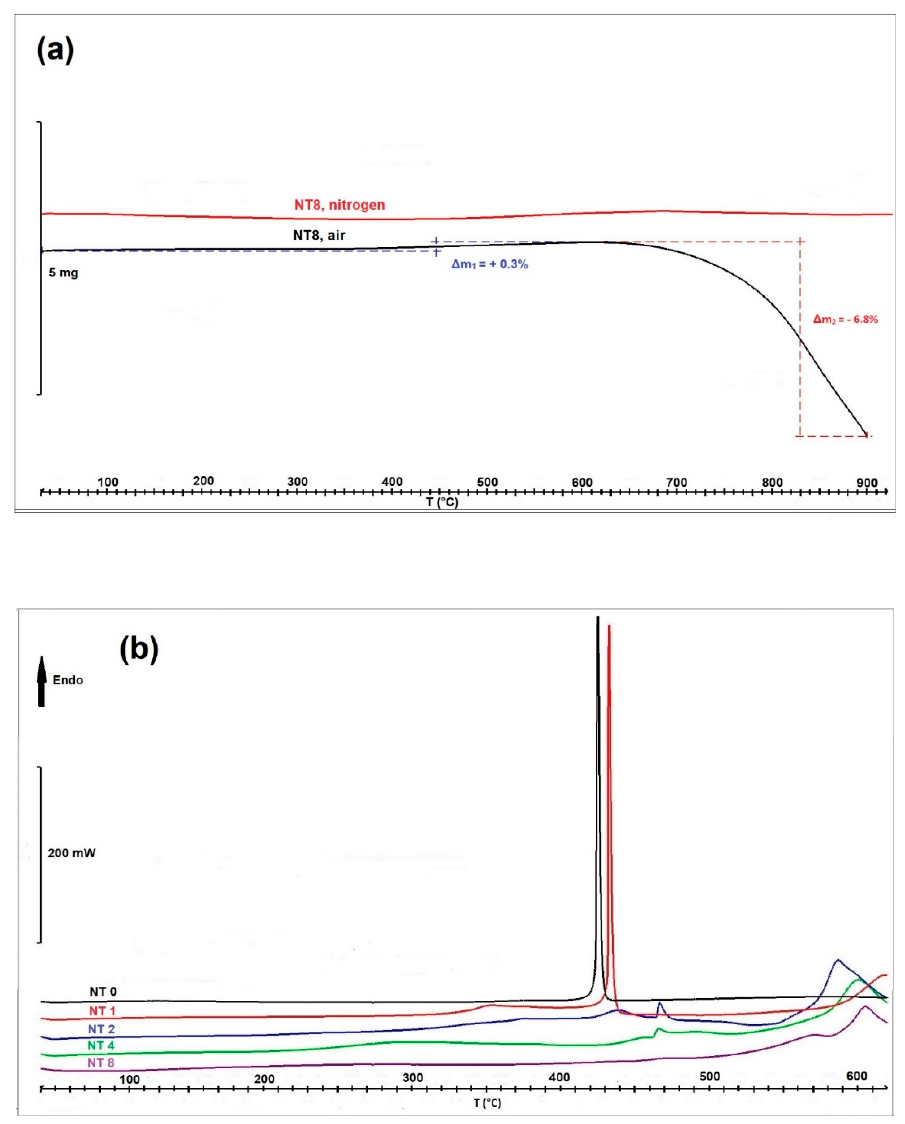
Figure 9. TGA curves of mechanochemically prepared NiTe in nitrogen and air ( a ) and DSC curves of NiTe samples after different milling times measured in nitrogen ( b ).